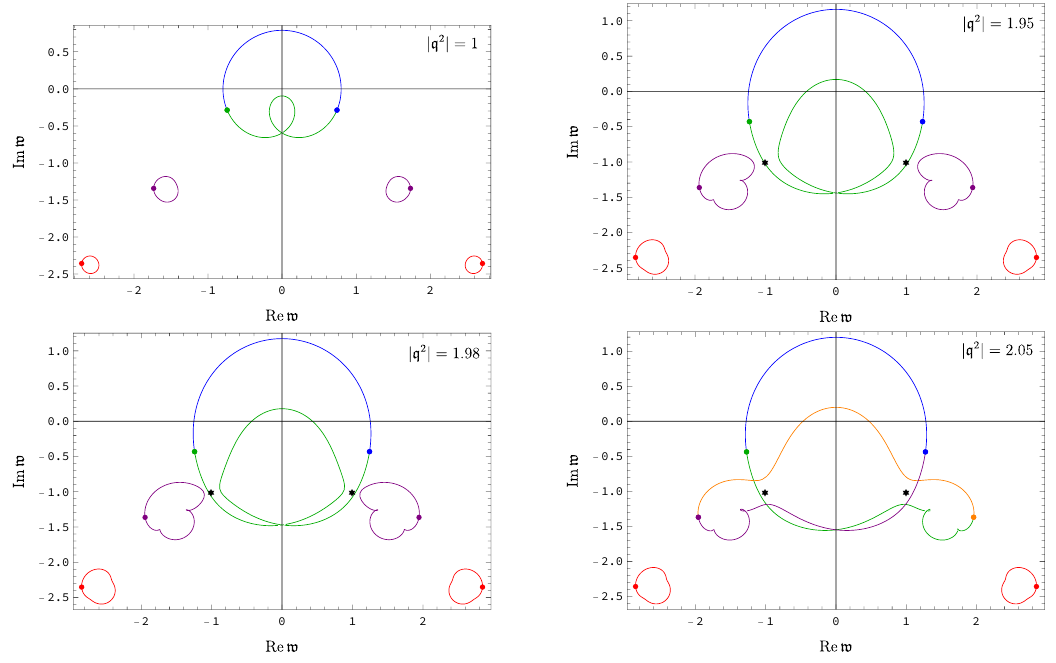
Figure 10 . Quasinormal spectrum (poles of the retarded energy-momentum tensor two-point function in the N = 4 SYM theory) in the sound channel plotted in the complex w -plane for di(cid:11)erent values of the complex momentum q 2 = j q 2 j e i(cid:18) . Large dots in all four plots correspond to the location of the poles for purely real momentum, q 2 (i.e. at (cid:18) = 0) [41]. The hydrodynamic sound poles are the blue and the green poles closest to the real axis. As (cid:18) is tuned from 0 to 2 (cid:25) , each pole moves in a counter-clockwise direction and follows the trajectory of its colour. At j q 2 j = 1 (top left panel), all poles follow a closed orbit. At j q 2 j = 1 : 95 (top right panel), the trajectory of the two hydrodynamic sound poles comes close to the trajectories of the nearest gapped poles. With j q 2 j further increasing to j q 2 j = 1 : 98, the poles nearly collide at the positions marked by asterisks (bottom left panel). The actual collision occurs at the critical value of the momentum (4.32), j q 2 j = 2. At j q 2 j = 2 : 05 (bottom right panel), the orbits of the four uppermost poles are no longer c closed: the hydrodynamic poles and the two gapped poles exchange their positions cyclically as the phase (cid:18) increases from 0 to 2 (cid:25) | again, a manifestation of the quasinormal mode level-crossing. The dispersion relation w ( q ) therefore has branch cuts starting at q c